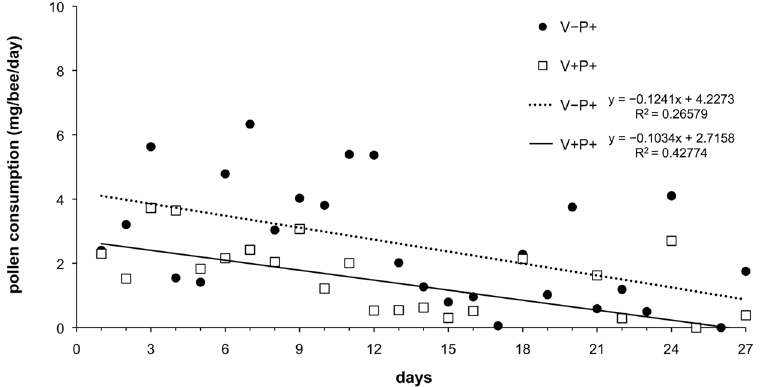
Figure 2. Pollen consumption of Varroa infested (V + ) and uninfested (V − ) bees over the period of the lab trial.